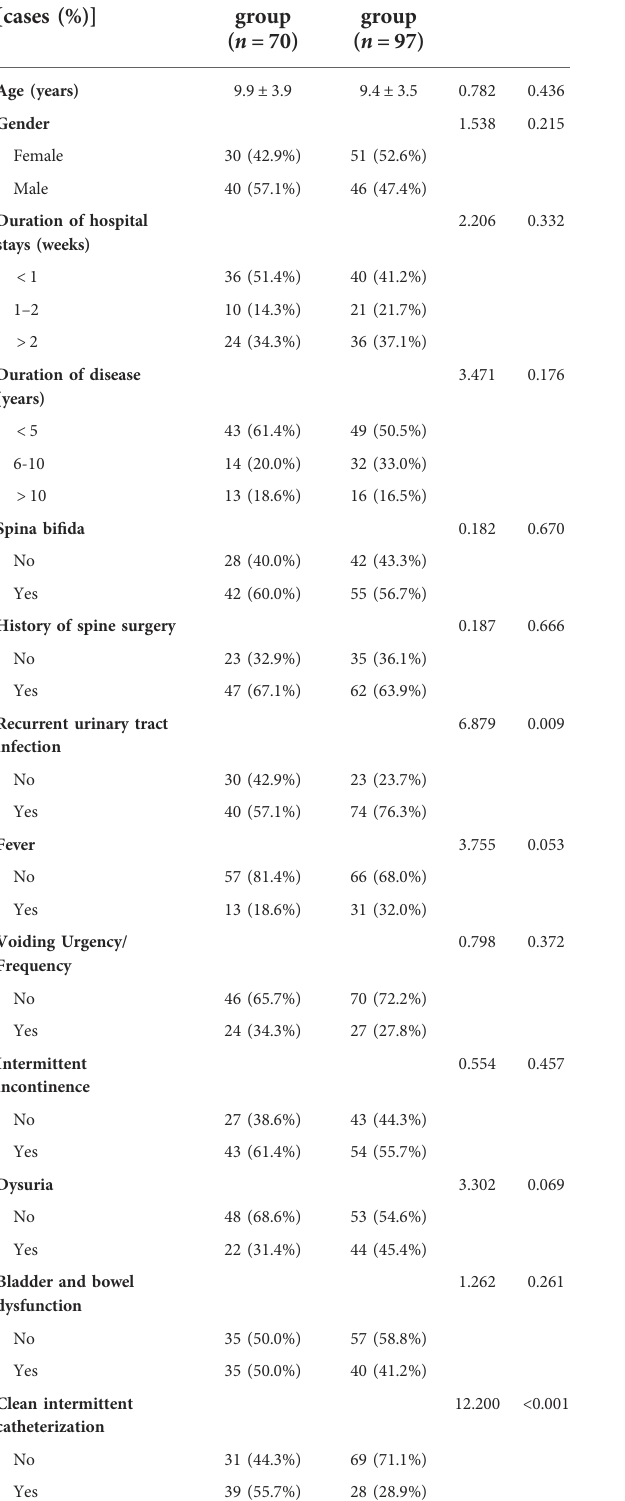
TABLE 2 Univariate analysis of variables associated with upper urinary tract damage in the training cohort. Characteristics